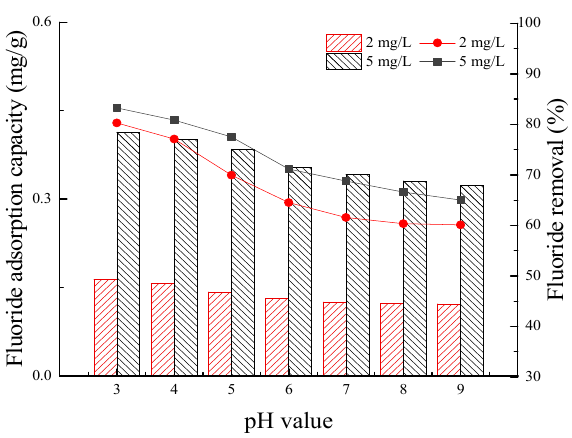
Figure 8. Effect of pH on fluoride removal by MnOOH-supported AA.